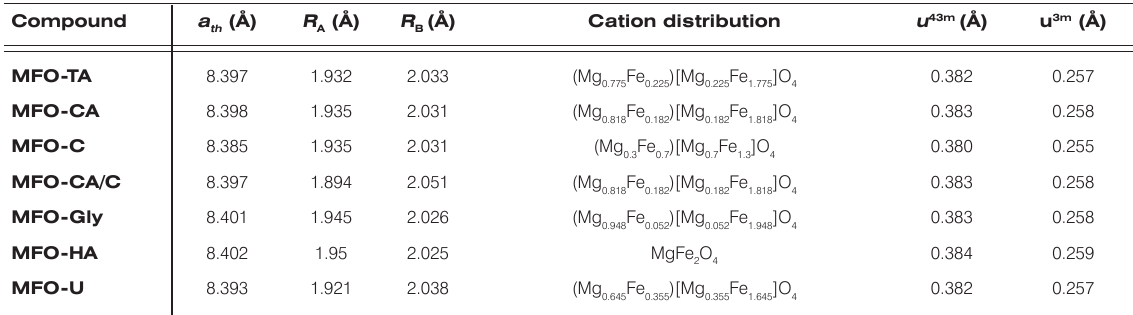
Table 4. Theoretical lattice parameter ( a Compound